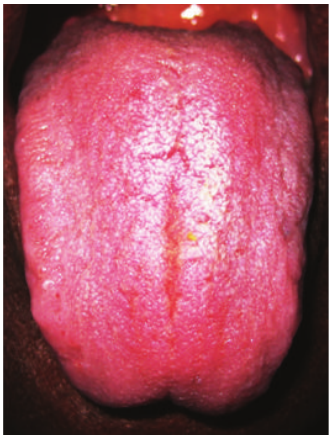
Figure 2: Central transverse type.